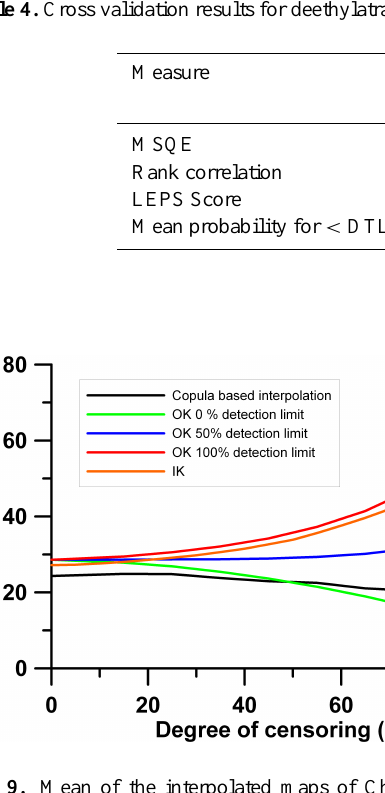
Fig. 10. Frequency of observations in the 80 % confidence interval for V-copula based interpolation (long dashes) and Gauss-copula based interpolation (short dashes) and indicator kriging (dashed dotted line) for differentgradesofcensoringofChloride.